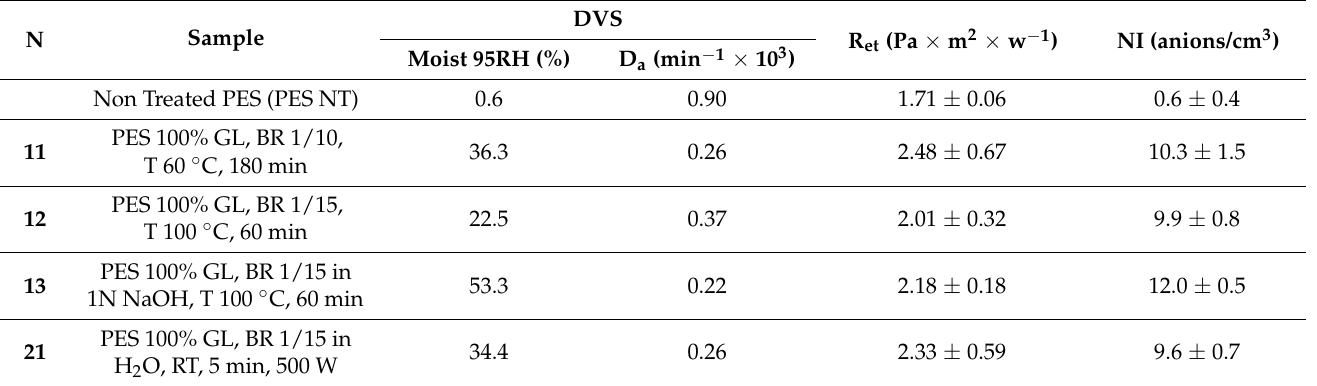
Table 4. Moisture at 95%RH and Apparent Diffusion (D a ) by Dynamic Vapor Sorption, Water Vapor Resistance (R et ) and Negative Ions (NI) of the different textiles, and PES treated with GL at the optimized experimental